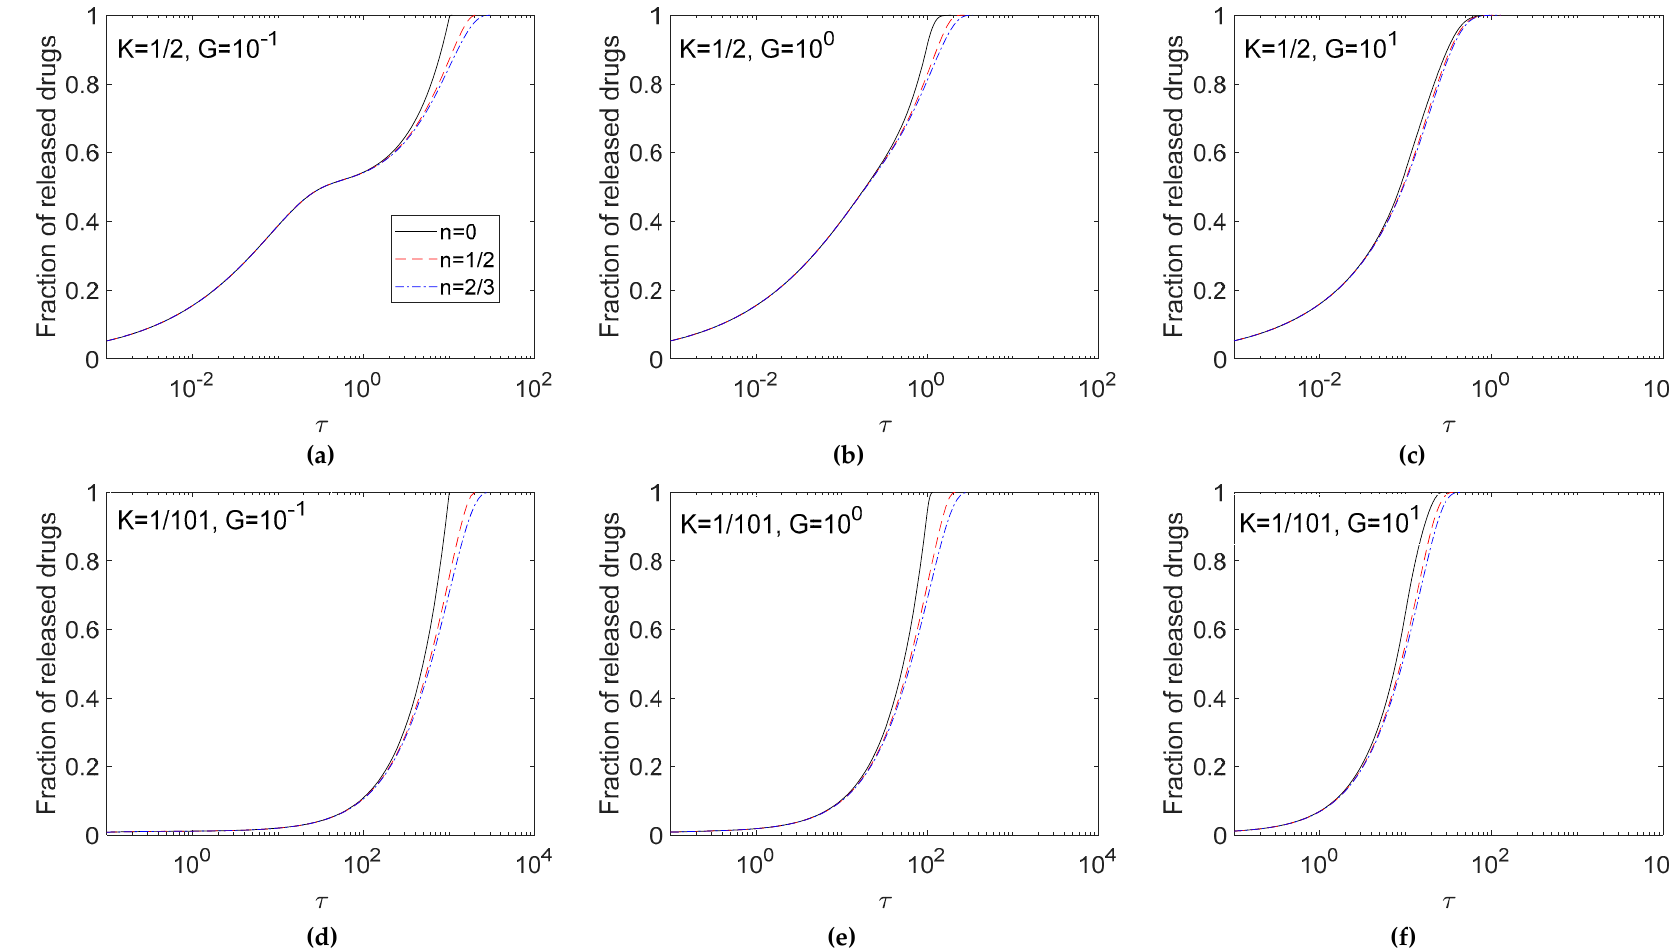
Figure 3. Effect of n on release fractions for K = 1/2 ( a – c ) and K = 1/101( d – f ). Calculations are carried out for G = 10 − 1 ( a , d ), 10 0 ( b , e ) and 10 1 ( c , f ).